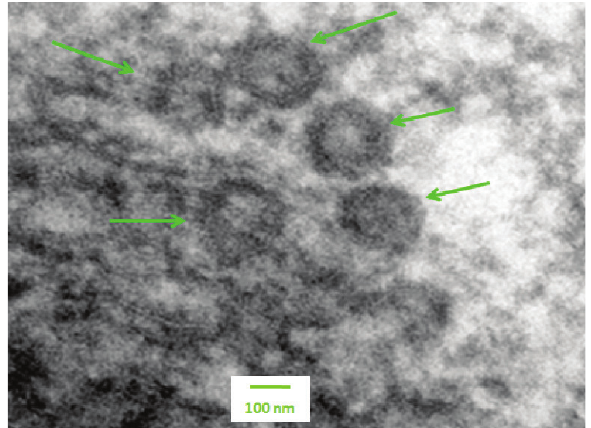
Figura 12. Embrião exposto aos vírus (Grupo G para as partículas virais (setas verdes) encontradas no citosol. Aumento: 120.000x.